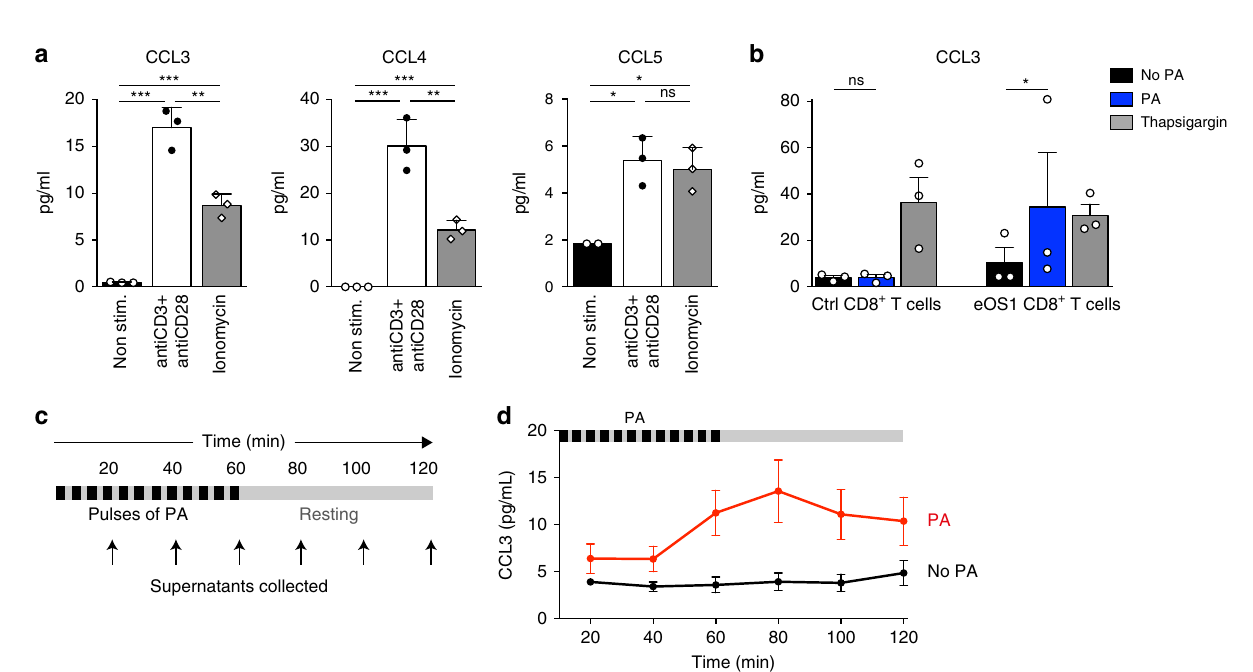
Fig. 2 Optogenetic manipulation of calcium signals in migrating T cells in vitro. a eOS1-expressing B3Z T cell clones were deposited on Poly-L-Lysine (PLL) and ICAM-1-coated dishes and visualized by videomicroscopy and photoactivated with a 100 ms pulse of blue light. a Left, representative images showing the morphology of B3Z cells during ameboid migration (before PA), arrest and rounding up (after PA), and subsequent spreading and adhesion. Scale bar: 10 μ m. Times are in min:sec. Middle, quanti fi cation of B3Z cells roundness and spreading (cell area) before and after PA. Each dot represents one cell. Bars represent mean values. Groups were compared using a two-tailed Mann – Whitney test (*** p < 0.001). Representative of three independent experiments. Right, mean velocity of B3Z cells graphs as the function of time. Representative of six independent experiments. b , c Calcium in fl ux is required for B3Z T cell arrest and adhesion. b B3Z cells were stained with Indo-1, resuspended in medium containing the indicated concentration of EGTA to totally (1 mM) or partially (0.5 mM) chelate extracellular Ca 2 + and analyzed by fl ow cytometry. Thapsigargin was added at the indicated time point during the acquisition. Representative of two independent experiments. c Velocity and cell area of eOS1-expressing B3Z cells migrating on PLL + ICAM-1-coated surface and in the presence of the indicated concentration of EGTA are quanti fi ed before and after photoactivation. Representative of four independent experiments. Bars represent mean values. Groups were compared using a two-tailed Mann – Whitney test (** p < 0.01, *** p < 0.001). d eOS1-expressing B3Z cells were visualized migrating on PLL alone or PLL + ICAM-1-coated surfaces and subjected to photoactivation. Representative images (left) and cell area quanti fi cation (right) showing B3Z cell spreading after photoactivation occurs only in the presence of ICAM-1. Scale bar: 20 μ m. Times are in min:sec. Representative of four independent experiments. Bars represent mean values. Groups were compared using a two-tailed Mann – Whitney test (ns p = 0.4715, * p = 0.01, *** p < 0.001). e Repeated photoactivations prolong B3Z T cell arrest (left) and limit cell spreading (right). B3Z cells were subjected to a single or multiple photoactivation (100 ms every 5 min). Representative of three independent experiments. Bars represent mean values. Groups were compared using a two-tailed Mann – Whitney test (ns p = 0.9257 and 0.4821, *** p < 0.001). f CD8 + T cells were activated and transduced to express eOS1, then deposited on PLL + ICAM-1-coated dishes before being subjected to a single or repeated (every 5 min) photoactivations. Representative of two